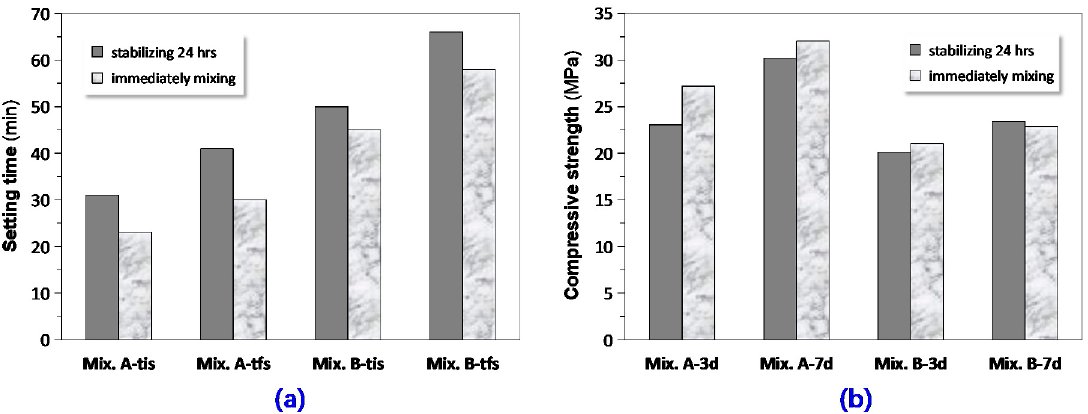
Figure 8. Influence of preparation procedure on basic properties of GPC: ( a ) setting time (tis = initial setting and tfs = final setting); ( b ) compressive strength at 3 and 7 days. In the two graphs, Mix. A and B stand for the GPC mixtures randomly extracted from the investigated mixtures.